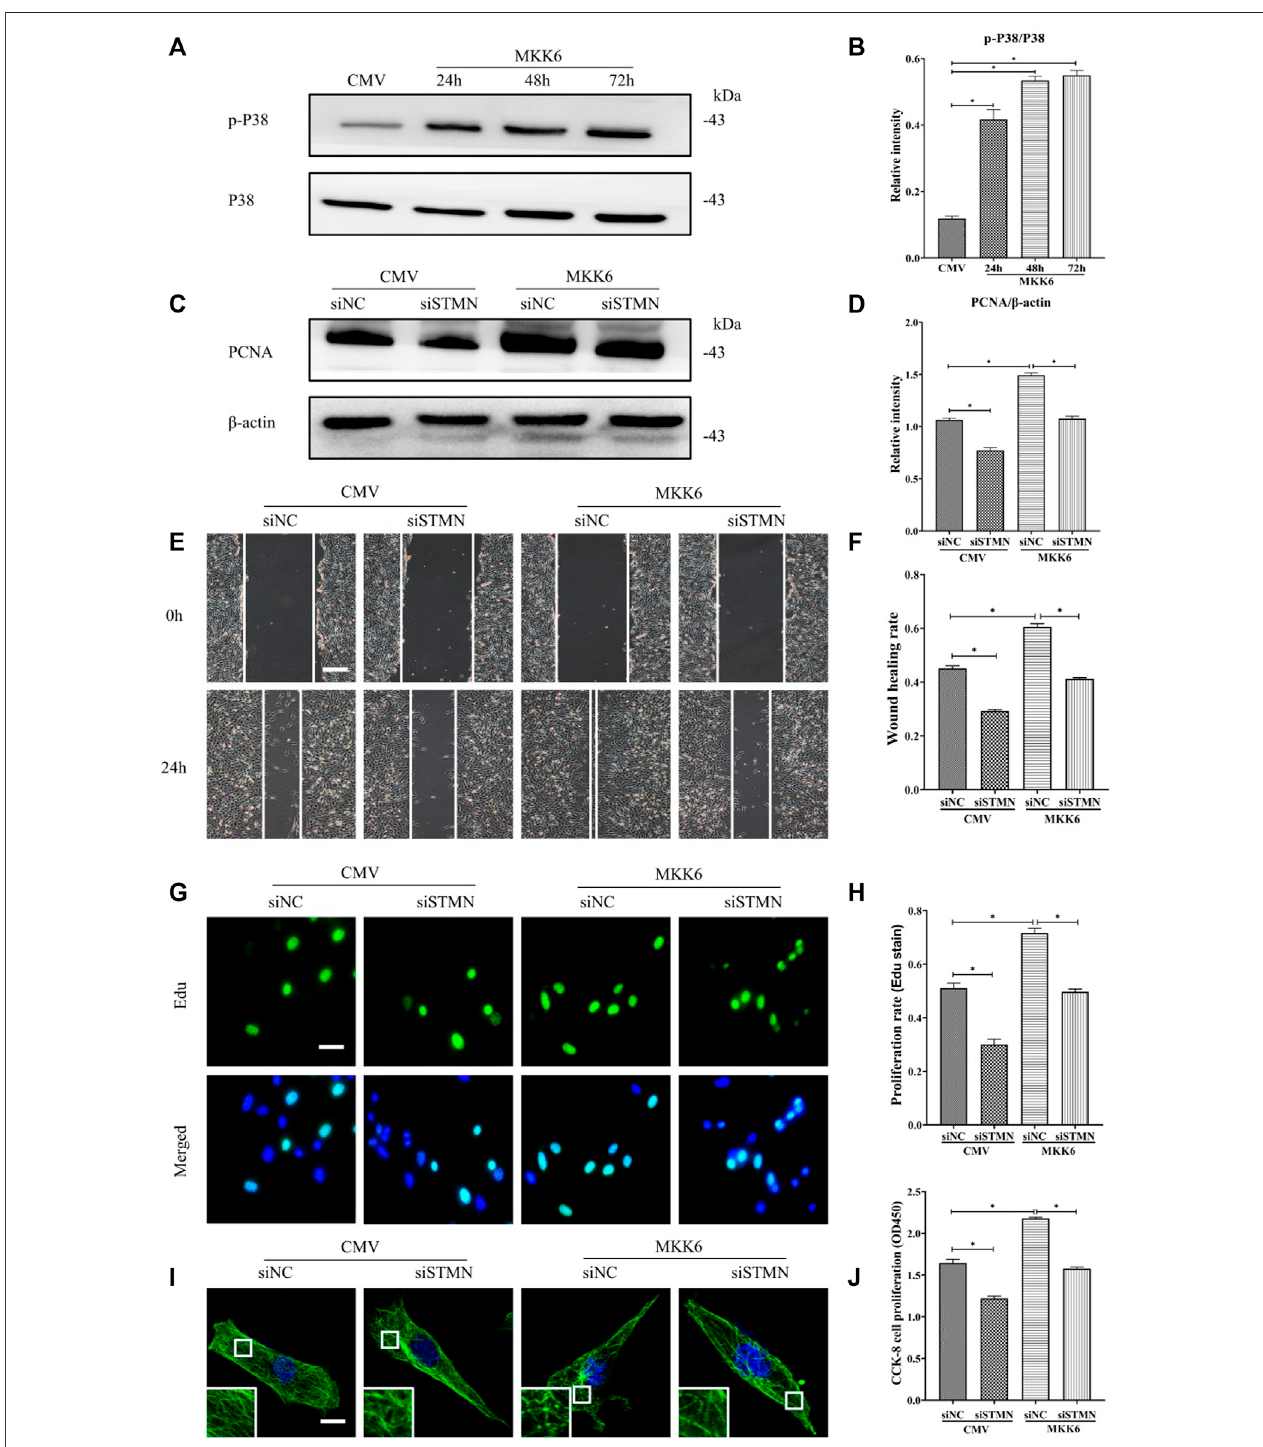
FIGURE 6| P38/MAPK induced HDF migration and proliferation via stathmin-dependent MT depolymerization. (A) Western blotting was performed toanalyze the effects of MKK6(Glu) transfection for the indicated times, and (B) the results were quantitatively analyzed ( n (cid:1) 3). (C) Western blotting was performed to detect PCNA expression after the cells were transfected or cotransfected with siSTMN or MKK6(Glu), and (D) the results were quantitatively analyzed ( n (cid:1) 5). (E) Scratch wound healing assays were performed to detect HDF migration after cells were transfected or cotransfected with siSTMN or MKK6(Glu). Bar, 200 μ m, and (F) the results werequantitativelyanalyzed ( n (cid:1) 5). (G) HDFproliferationwasdetected afterthecellsweretransfectedorcotransfectedwithsiSTMNorMKK6(Glu)byEdUstaining,and (H) the results were quantitatively analyzed ( n (cid:1) 5). Nuclei were stained with Hoechst 33342. The merged image is to show the proportion of proliferating cells (green)